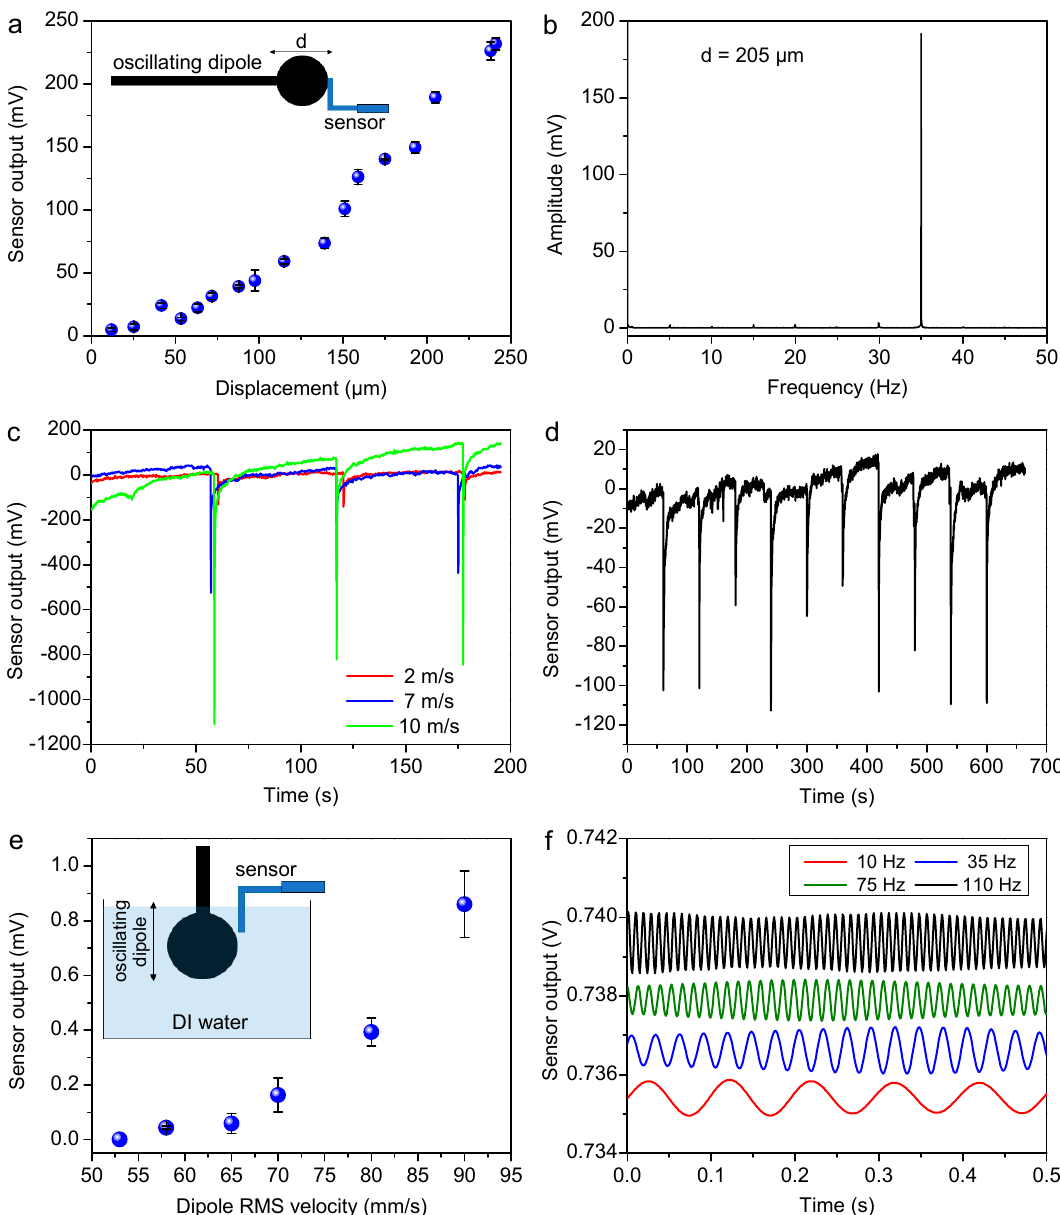
Figure 5. Sensor tests: ( a ) oscillatory tactile stimuli; ( b ) example of FFT peak at 35 Hz for d = 205 µ m; ( c ) compressed air stimuli along X-axis; ( d ) respiratory exhalation along Y-axis; ( e ) oscillatory flow stimuli in DI water (RMS velocity sweep); ( f ) oscillatory flow stimuli in DI water (frequency sweep).